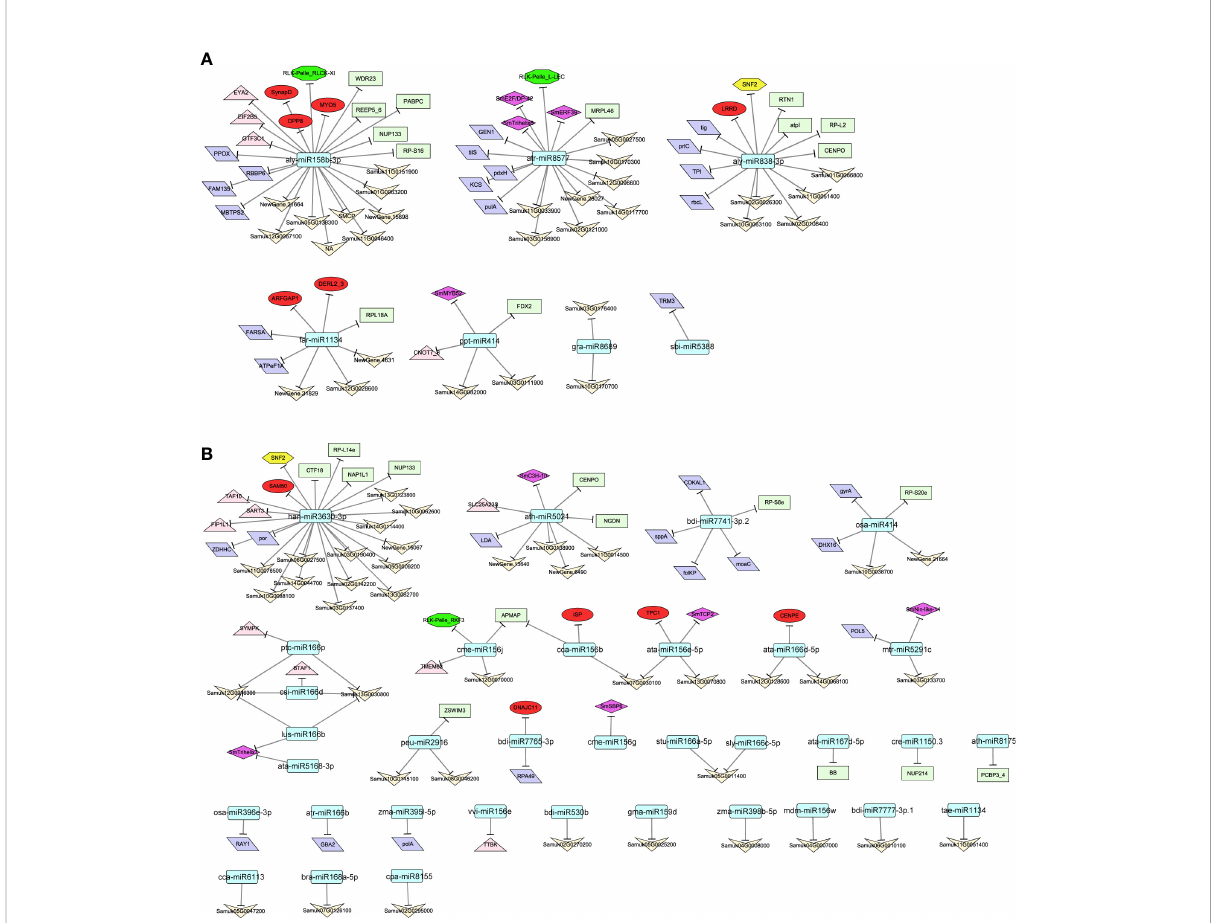
FIGURE 6 Regulatory network of negatively – correlated miRNAs and mRNAs in identi fi ed modules. miRNAs in modules Mebrown (A) and Meblue (B) that were signi fi cantly associated with saponin biosynthesis and were negatively correlated with various mRNAs as indicated by the arrows. Round rectangle, diamond, hexagon, octagon, ellipse, parallelogram, rectangle, triangle, and V represent miRNA, TFs, TRs, PKs, transporters, enzymes, proteins, others and unknow genes,